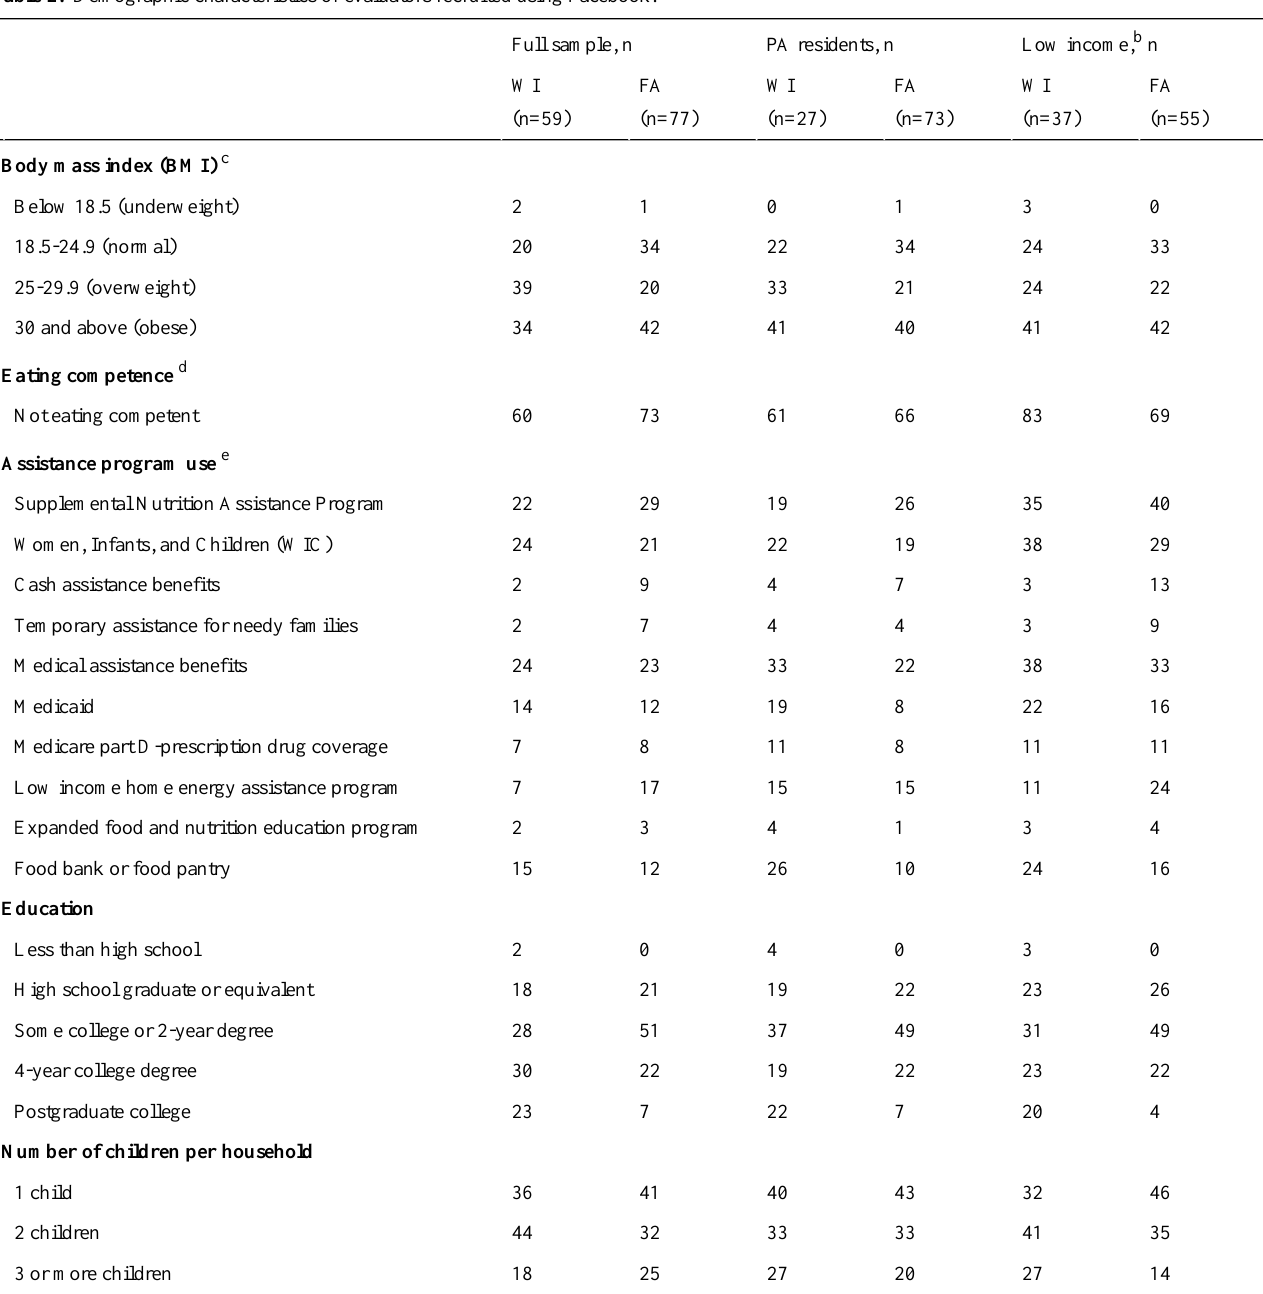
Table 2. Demographic characteristics of evaluators recruited using Facebook. a